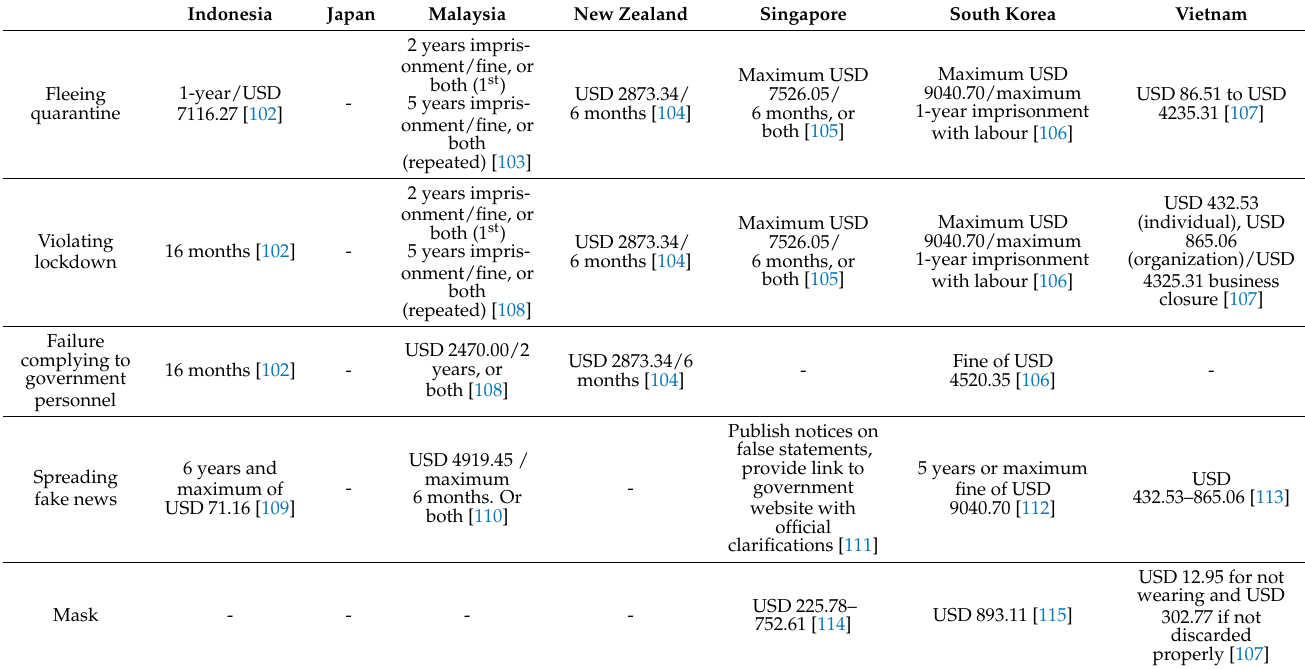
Table 12. A breakdown of penalties employed during